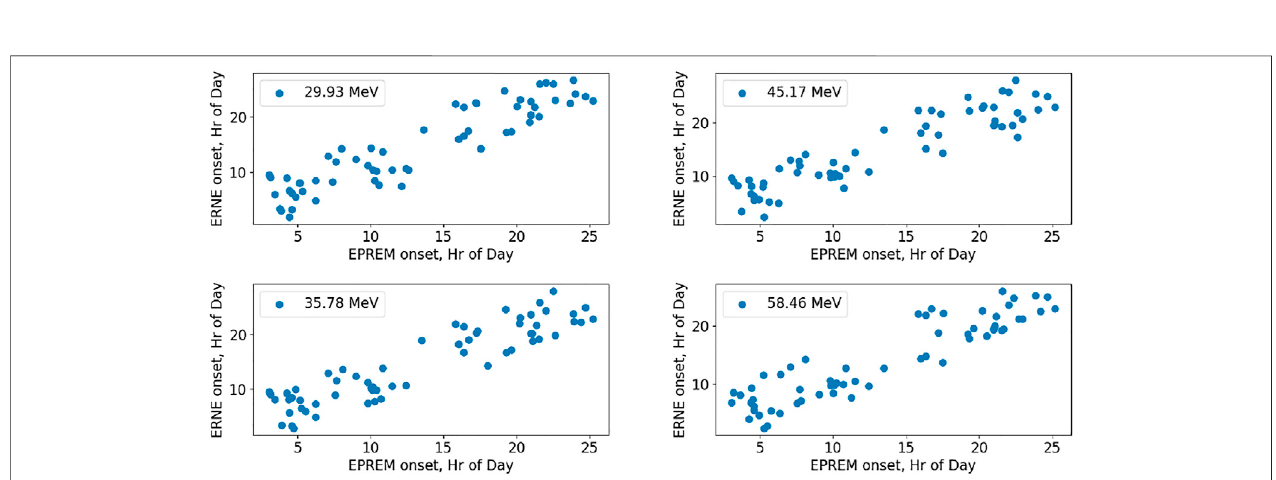
FIGURE 14 | Scatter plots of the onset times at four separate energies for EPREM model and ERNE observations, similar to the right plot in Figure 14 .